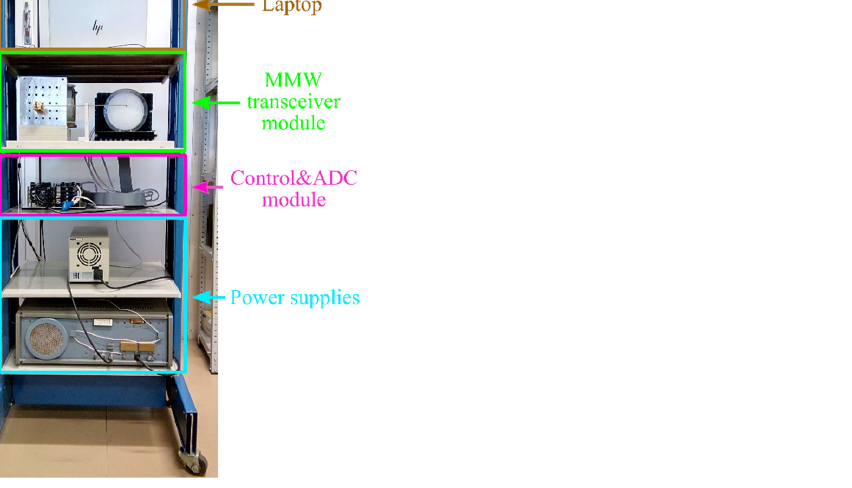
Figure 8. A photograph of the 8 × 8 array imaging system with designation of the modules, namely a MMW transceiver module, a control&ADC module, power supplies, and a